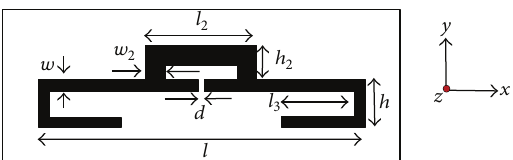
Figure 2: Dipole copper tag on Kapton substrate used as a reference tag for on-body measurements. The strap with the NXP IC [32] is attached over the 2 mm gap 𝑑 using conductive silver epoxy resin. The tag dimensions in mm are 𝑙 = 90 , 𝑙 2 = 30 , 𝑙 3 = 20 , 𝑤 = 3 , = 5 , ℎ = 13 , and ℎ = 9 𝑤 2 2